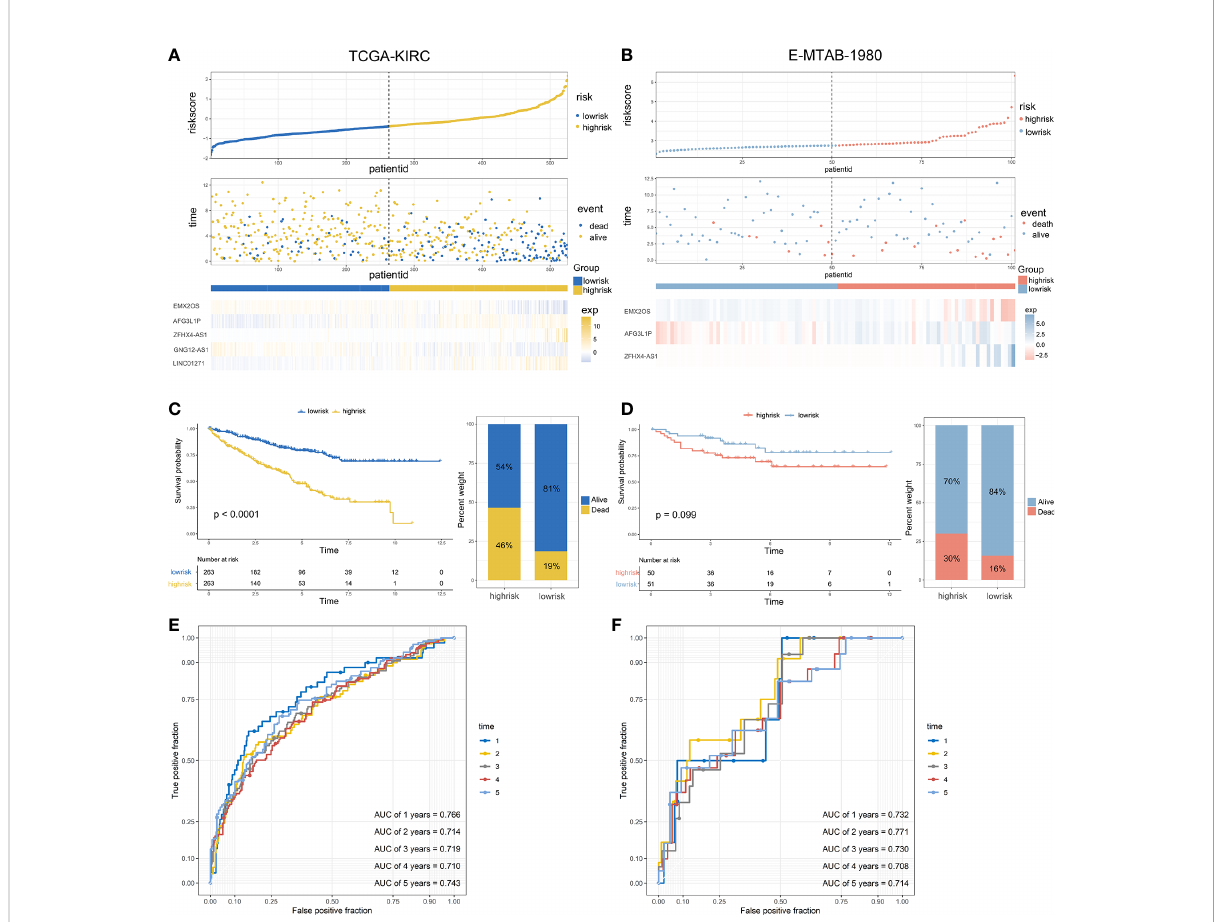
FIGURE 3 Validation of the predictive signature and performance analysis: (A, B) The riskscore distribution, survival status, and the expression of fi ve eRNAs of patients in the TCGA cohort and E-MTAB-1980 cohort. (C, D) Kaplan-Meier survival curves of OS and the proportion of the survival rate between the high- and low-risk groups of the two datasets. (E, F) Time-dependent receiver operating characteristic analysis of the two